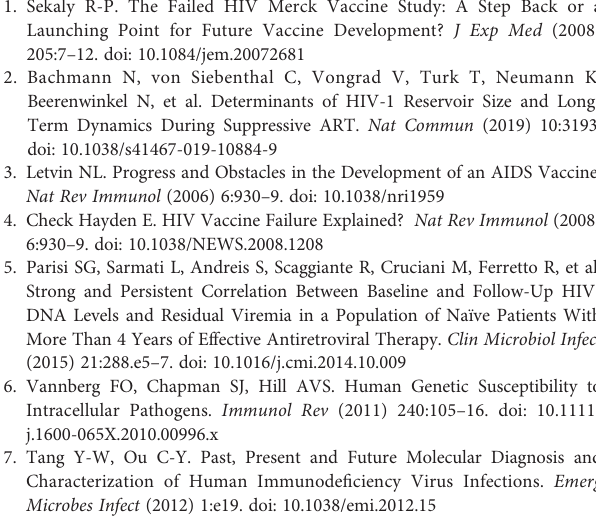
Supplementary Table 1 | Differences between complete cases database and after